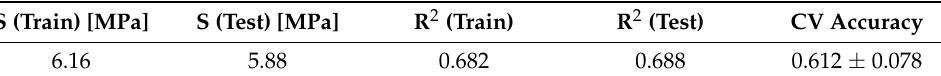
Table 6. Summary of prediction model summary based on ML.